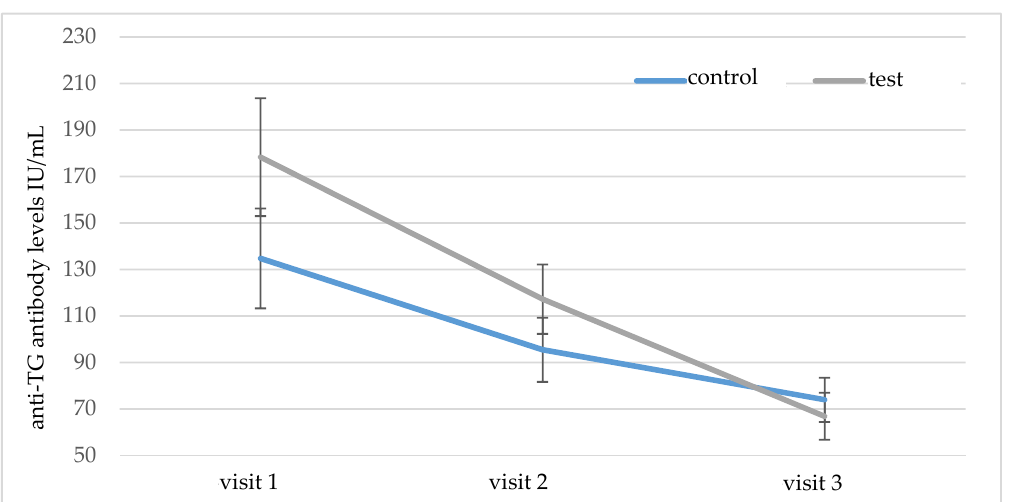
Figure 3. Comparison of test group A and control group B in terms of anti-TPO antibody levels during the six-month nutritional intervention.